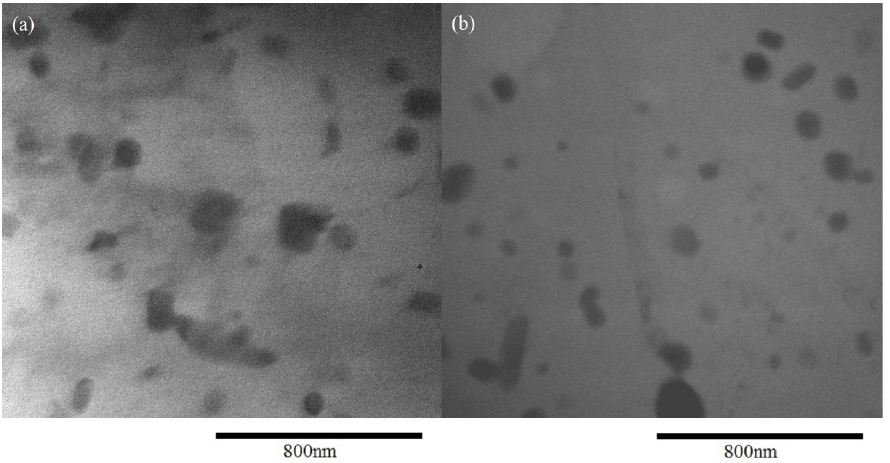
Figure 5. TEM photo show the plate-shape and lump-shape precipitate in the matrix of ( a ) T6 sample, and ( b ) CFT6a sample.